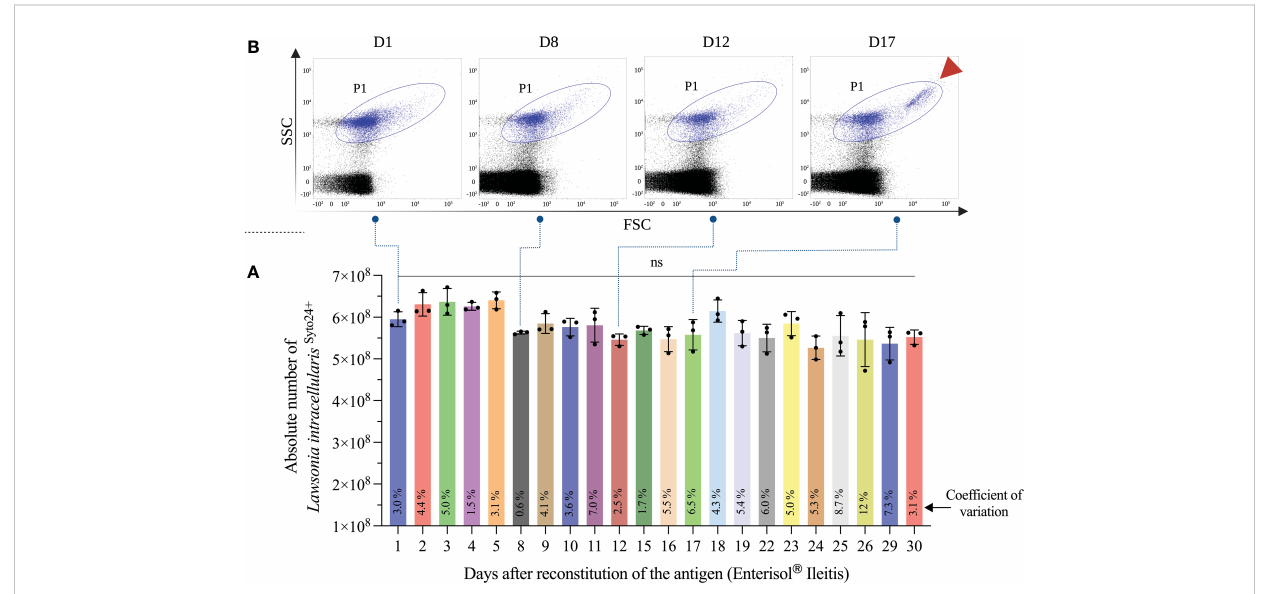
FIGURE 2 Antigen stability analysis. An aliquot of Enterisol ® Ileitis vaccine reconstituted and stored at 4-8°C was analyzed daily by fl ow cytometry. The aliquot diluted 1:1,000 was analyzed in triplicate and the mean of L. intracellularis absolute count plus standard deviation is shown in “ (A) ” . The coef fi cient of variation of each quanti fi cation is represented at the foot of the bars. The morphological characteristic of the bacterial population at 4 different times is illustrated in “ (B) ” . The subpopulation of L. intracellularis with greatest size and complexity is indicated with the arrowhead highlighted in red. Statistical comparison was performed using one-way ANOVA with Tukey ’ s multiple comparisons test and no signi fi cant (ns) differences were found between the moments